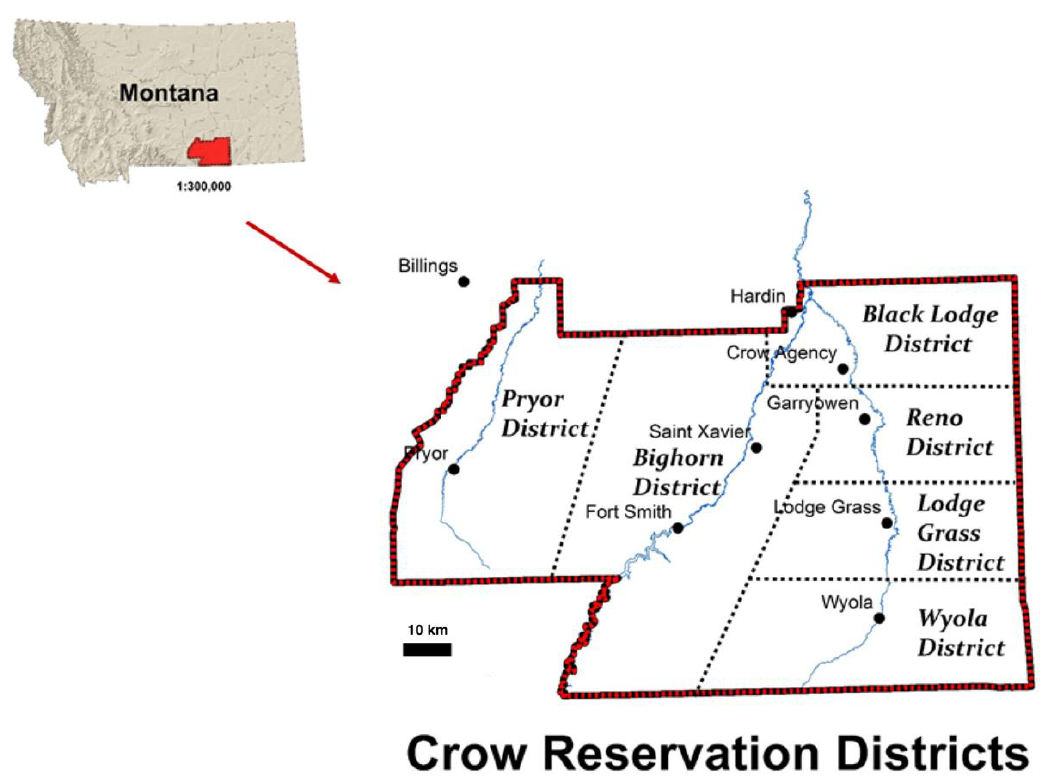
Figure 1. Map of the Crow Reservation, showing location within Montana, as well as major rivers, towns and districts of the Reservation [33]. All three rivers flow north, eventually joining the Yellowstone River.